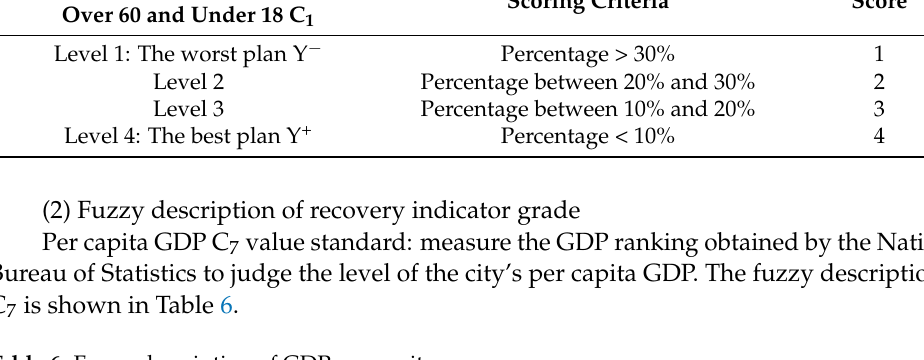
Table 6. Fuzzy description of GDP per capita. GDP Per Capita C 7